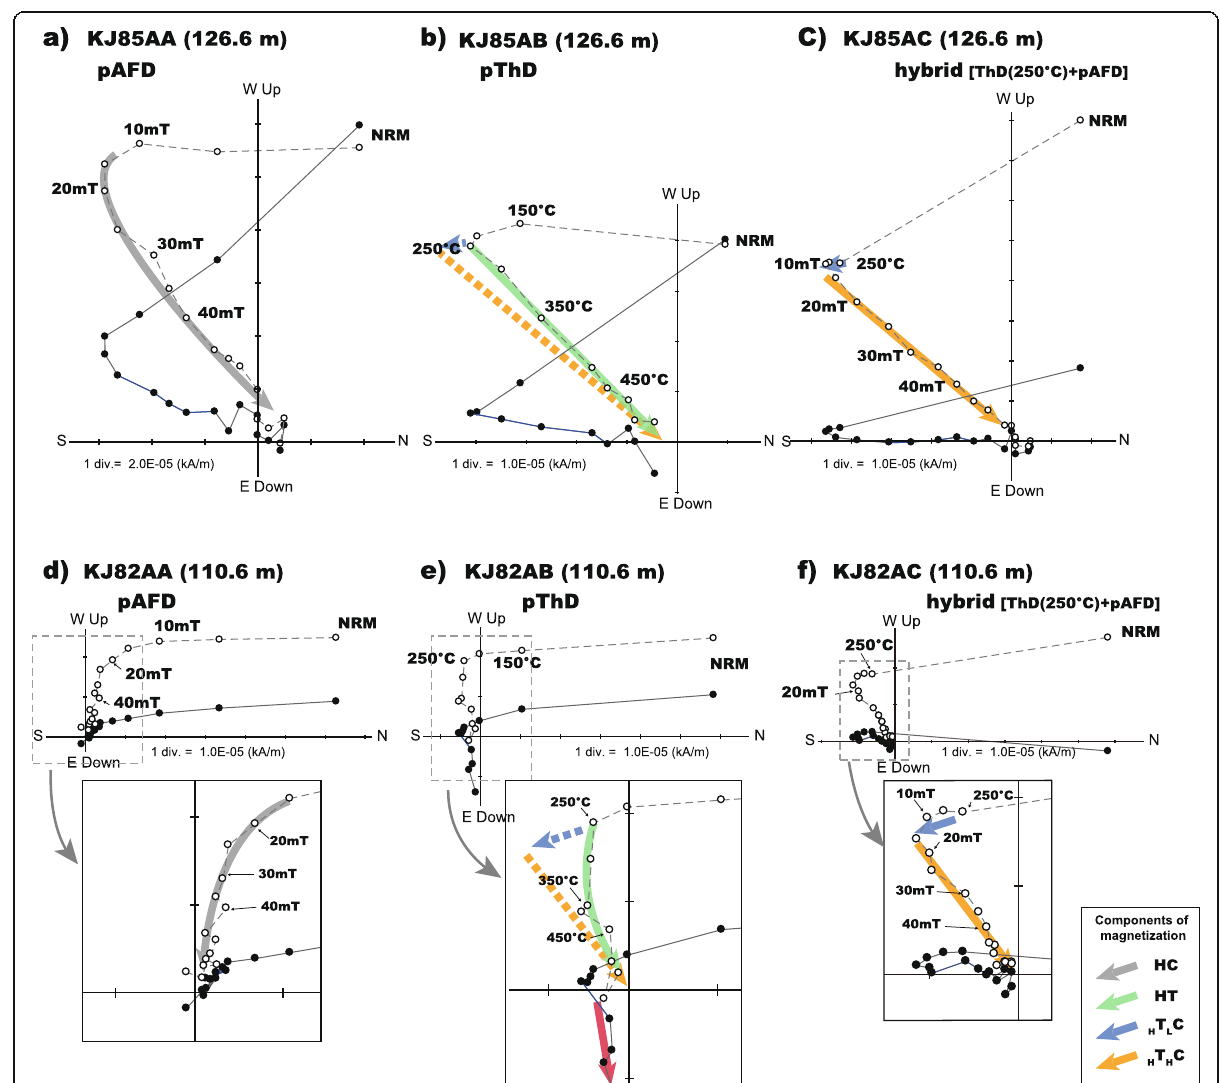
Fig. 6 Representative orthogonal vector diagrams. a – c Results from horizon KJ85. d-f Results from horizon KJ82. a , d Show the pAFD results. b , e Show the pThD results. c , f Show the hybrid results (pAFD after ThD at 250 °C). Closed and open circles indicate horizontal and vertical components, respectively. The grey arrows indicate the high-coercivity (HC) components in pAFD, whereas the green arrows indicate the high unblocking temperature (HT) components in pThD. The blue and orange arrows in hybrid indicate the low-coercivity components in HT ( H T L C) and the high-coercivity components in HT ( H T H C),